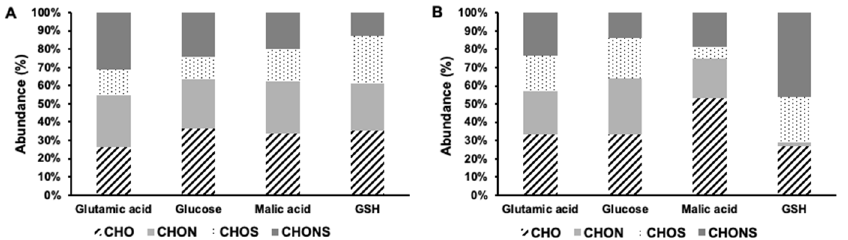
Figure 4. Elemental composition of phenolic compounds associated with ( A ) the minimum and ( B ) maximum growth rates. Different superscript letters indicate significant differences ( p < 0.05) deter- mined by Wilcoxon test.